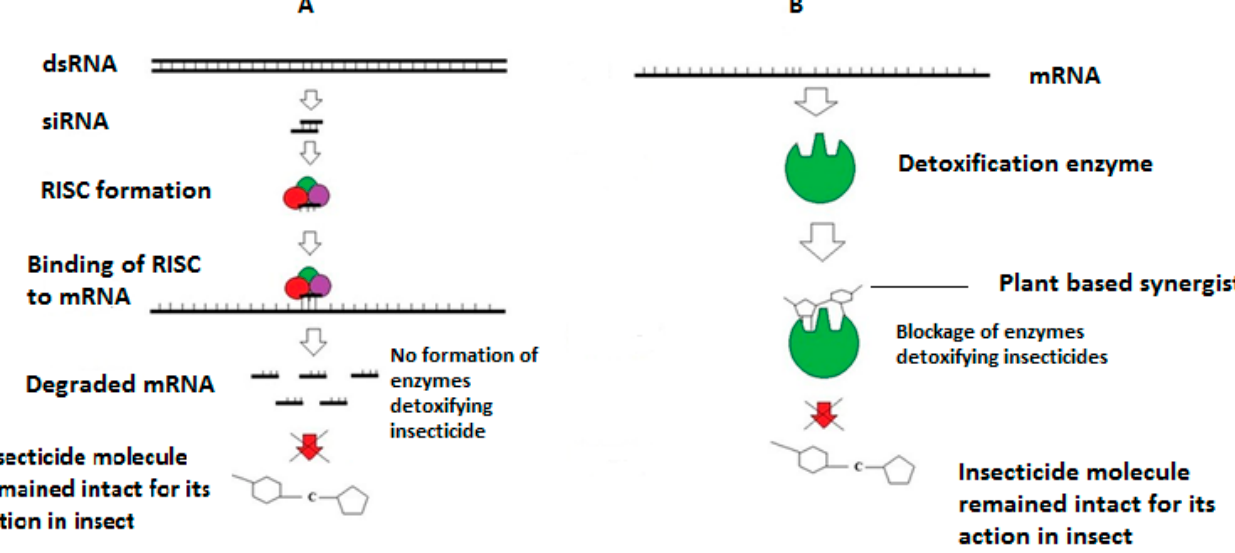
Figure 1. Difference between ( A ) siRNA-mediated synergism due to mRNA degradation and hence no detoxification of insecticides and ( B ) Plant-based synergism due to physical blockage of detoxi- fication enzymes resulting in no detoxification of insecticide(s). Adapted from Cooper et al. (2018) after changes.